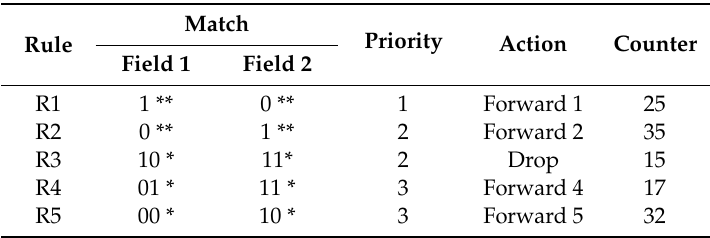
Table 1. An example of an OpenFlow flow table. OpenFlow rules contain multiple fields, including match, action, counter, and priority. Match Priority Action Counter Rule Field